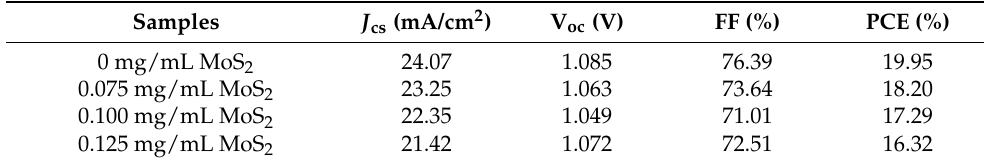
Table 3. Relevant device parameters obtained from J-V curves. Samples